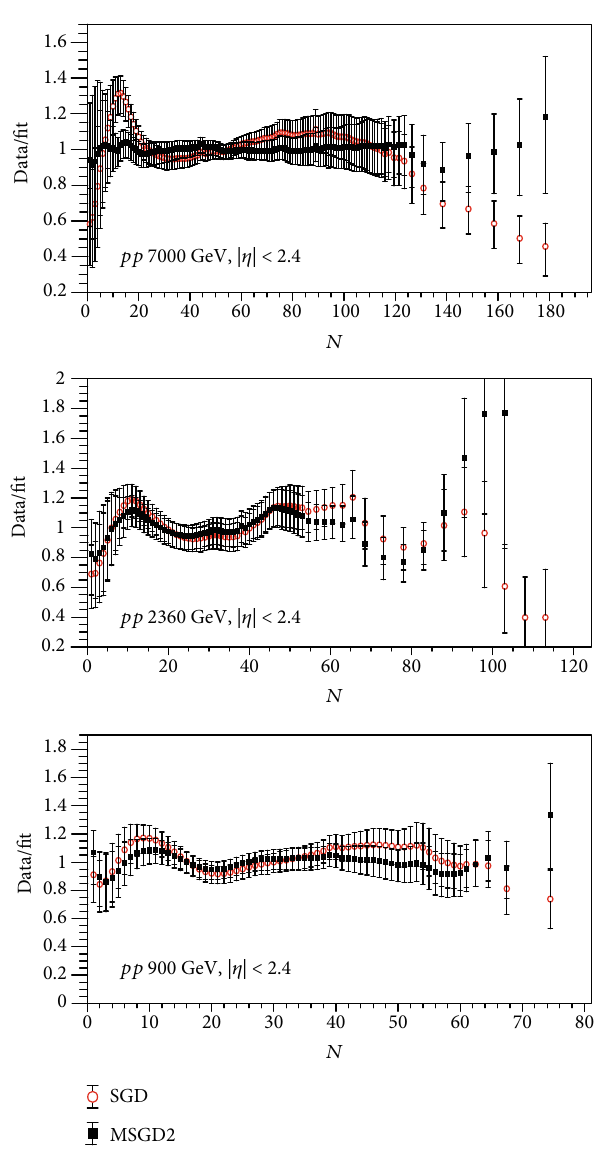
ð N Þ / P ð N Þ for the pp data shown in data SGD